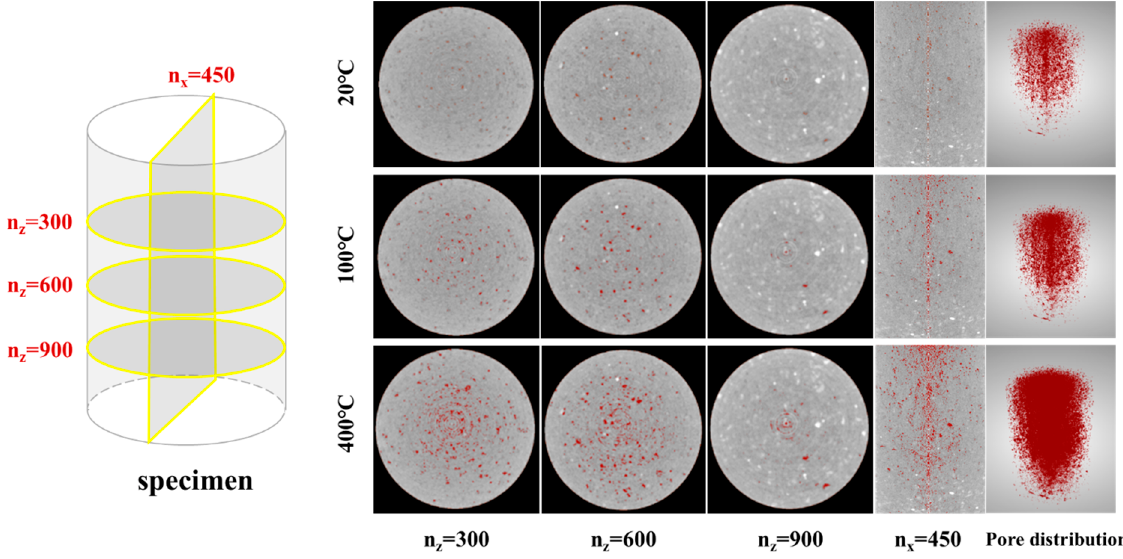
Figure 6. CT images of di ff erent sections and internal pores of